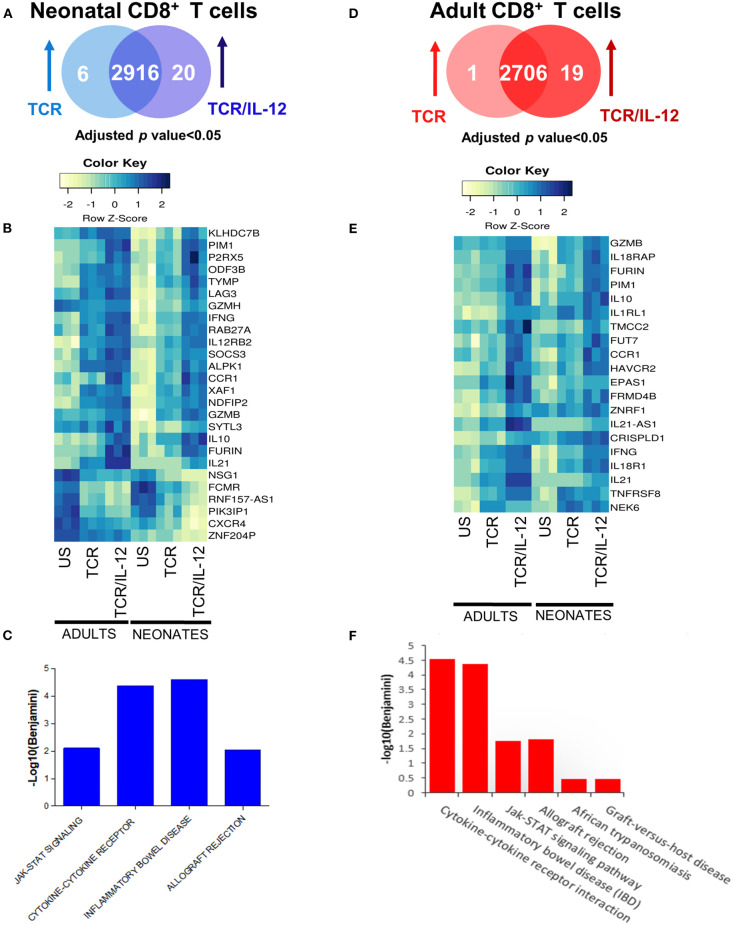
Comparison between TCR and TCR/IL-12 response genes of neonatal and adult naïve CD8+ T cells. (A,D) Venn diagrams (B,E) heatmaps of induced genes after TCR or TCR/IL-12 treatment of neonatal (left) and adult (right) CD8+ T cells (adjusted p < 0.05). (C,F) Enriched KEGG pathways returned by the DAVID software for the differentially expressed genes in neonatal (left) and adult (right) CD8+ T cells.